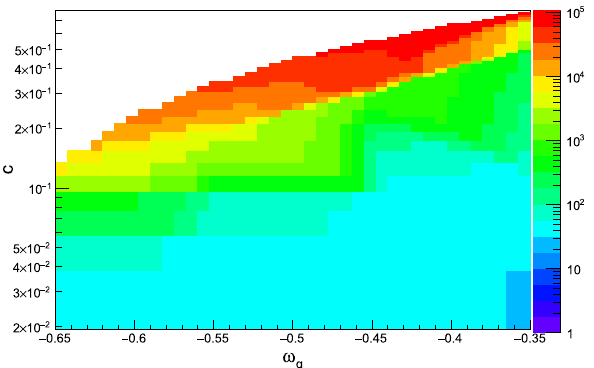
Fig. 7 Contour plot for ω q ∈] − 0 . 65 , − 0 . 35 [ . On the y axis are reported the excluded values of c due to the creation of a naked singu- larity (white part) and, on the right, the values of F ( R ph ) . It can be also seen the values of the parameter c , for which F ( R ph ) ∼ O ( 10 4 - 10 5 ) , that are excluded by the energy deposition bounds